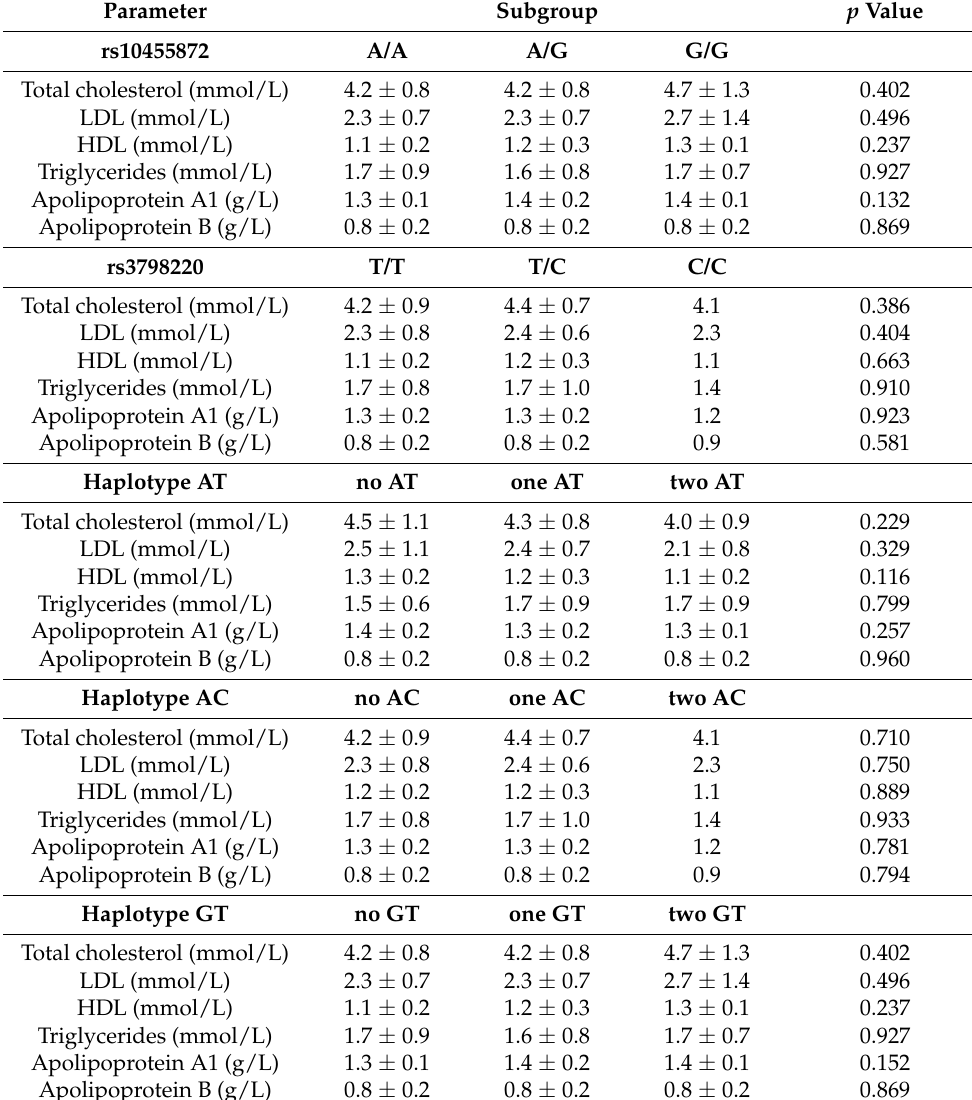
Table 3. Lipid profiles for the different LPA genotype and haplotype